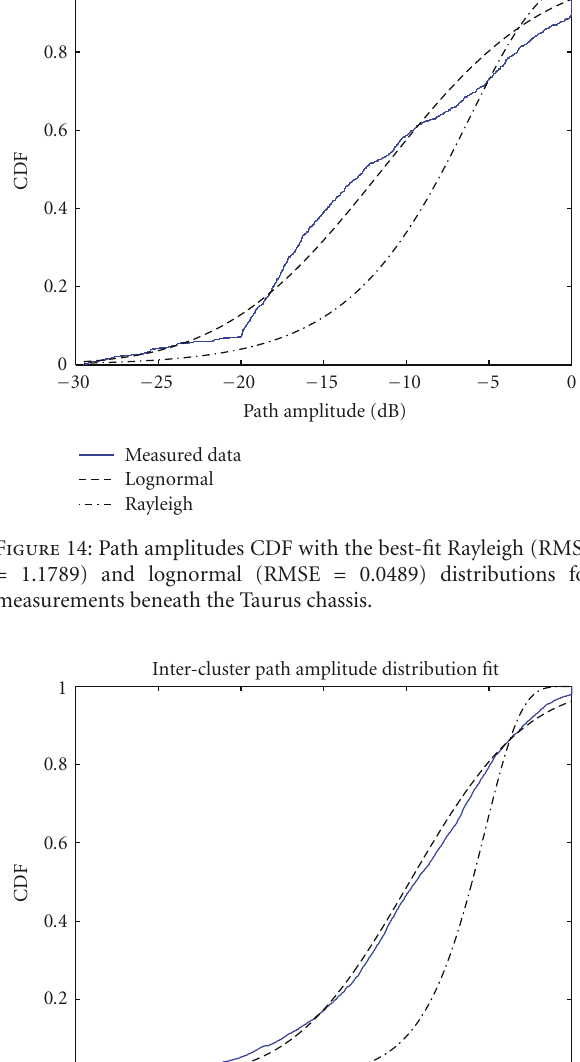
Table 1: Standard deviations of best-fit Rayleigh and lognormal distributions to the CDFs of path and cluster amplitudes.